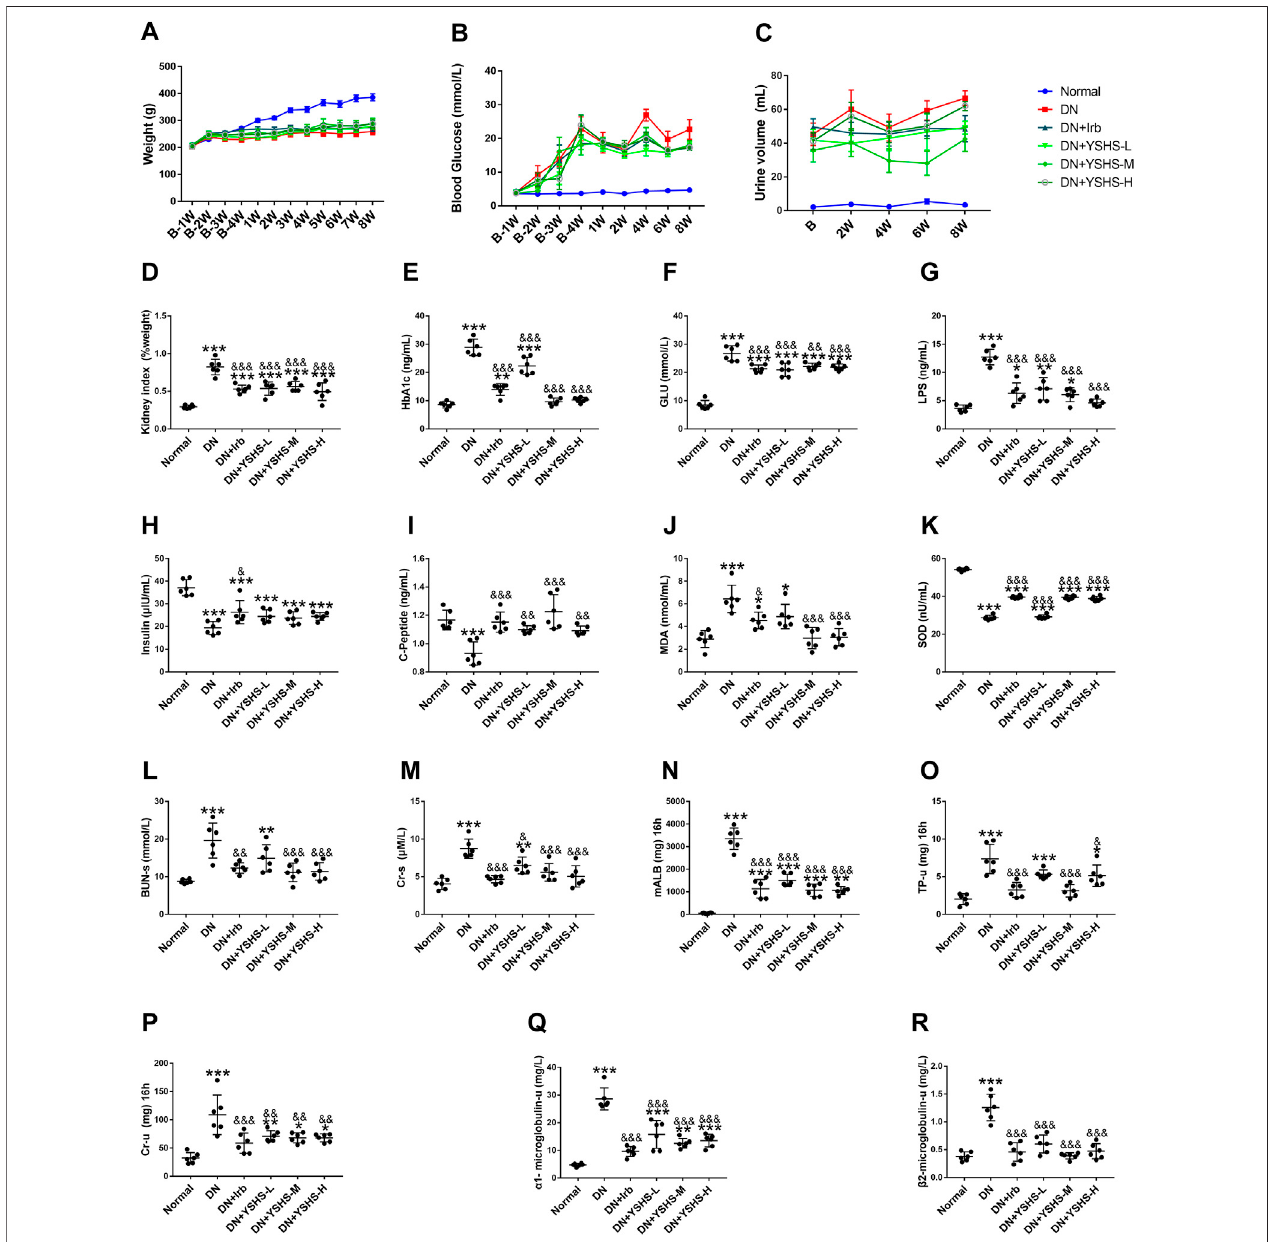
FIGURE 2 | Effect of YSHS on biochemical parameters in DN rats. Changes in body weight (A) , blood glucose (B) , and urine volume (C) throughout the experimentalperiod.Changesinkidneyindex (D) andparametersofbloodHbA1c (E) ,glucose (F) ,LPS (G) ,insulin (H) ,C-peptide (I) ,MDA (J) ,andSOD (K) attheendof the experiment. Changes of serum BUN-s (L) , Cr-s (M) , and mALB (N), TP-u (O) , Cr-u (P) , α 1-MG (Q), and β 2-MG (R) within urine at the end of the experiment. Values are presented as means ± SEM. * p < 0.05, ** p < 0.01, and *** p < 0.001, vs. Normal; & p < 0.05, & p < 0.01, and &&& p < 0.001, vs. DN.